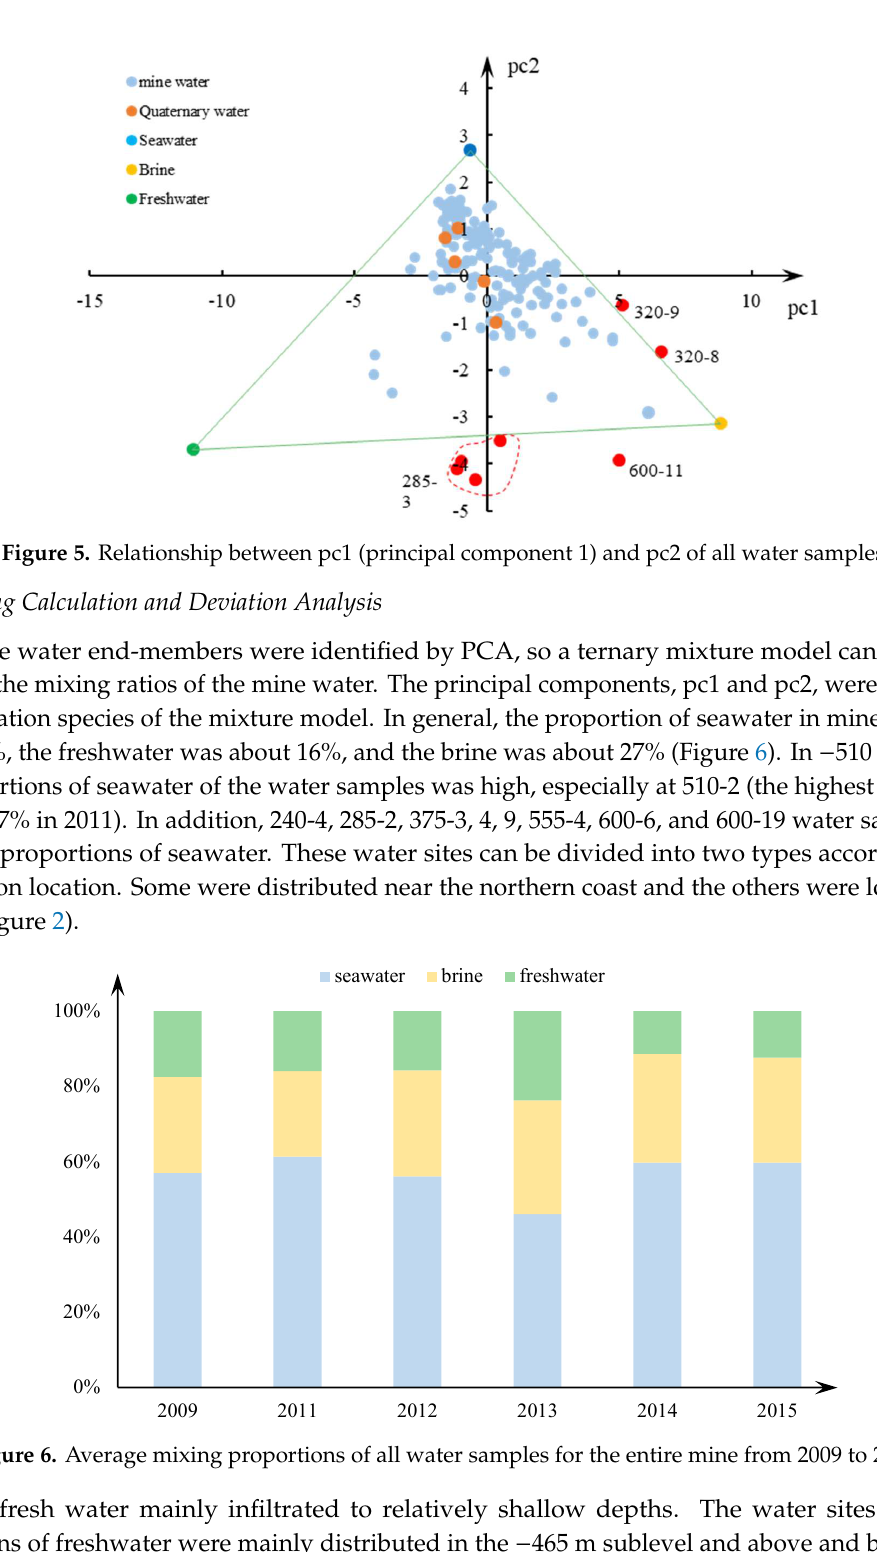
Table 3. Deviations of all ions and isotopes in two mixing models.